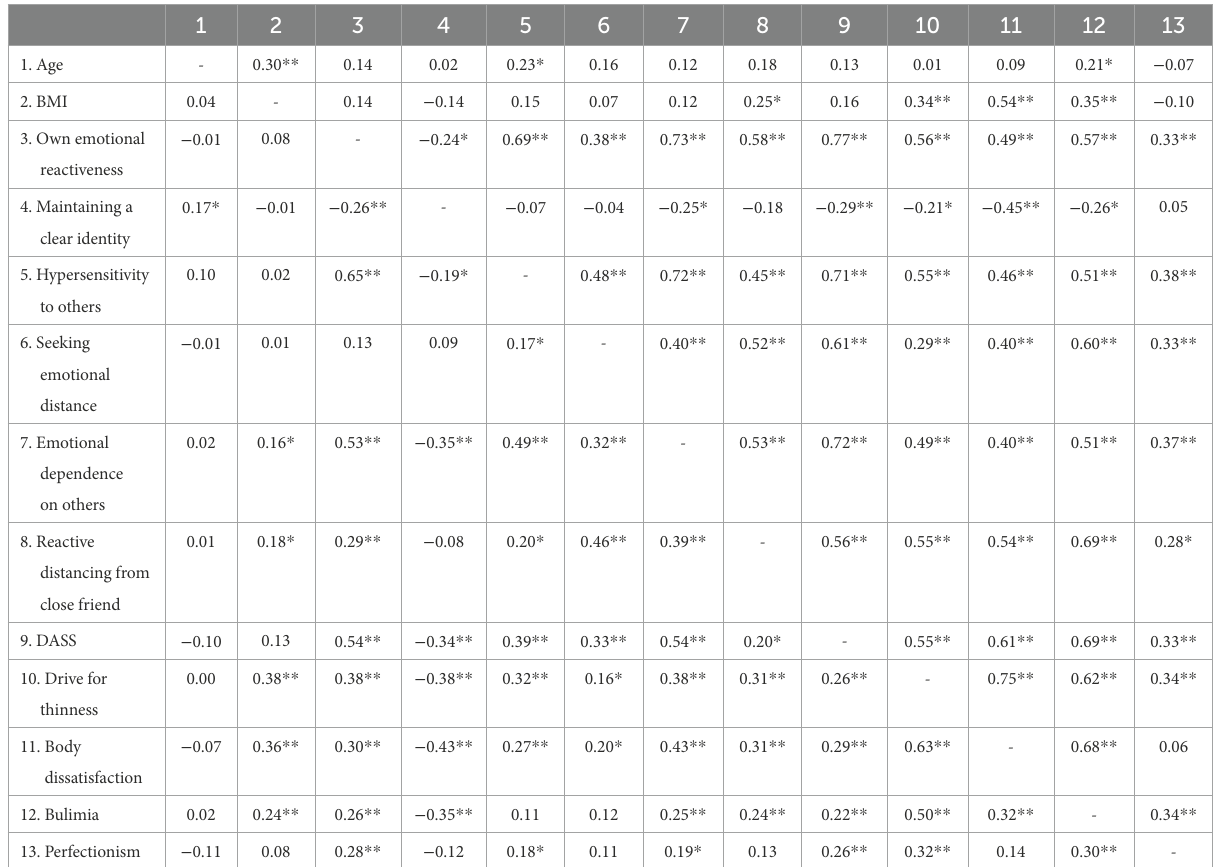
TABLE 3 Correlations between study variables by sex ( N =